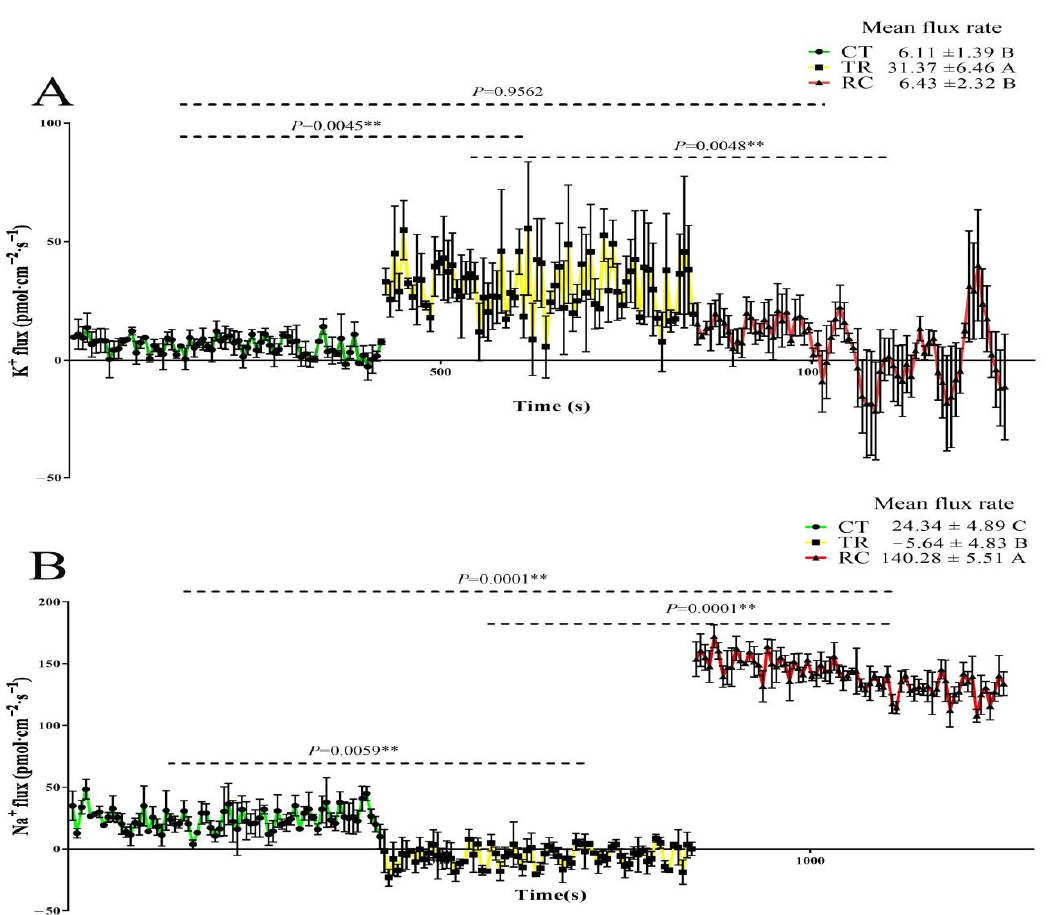
Figure 2. ( A ) The K + flux rate of root under CT, TR and RC. ( B ) The Na + flux rate of root under CT, TR and RC. Columns with different letters are significantly different (LSD test, p < 0.01). Error